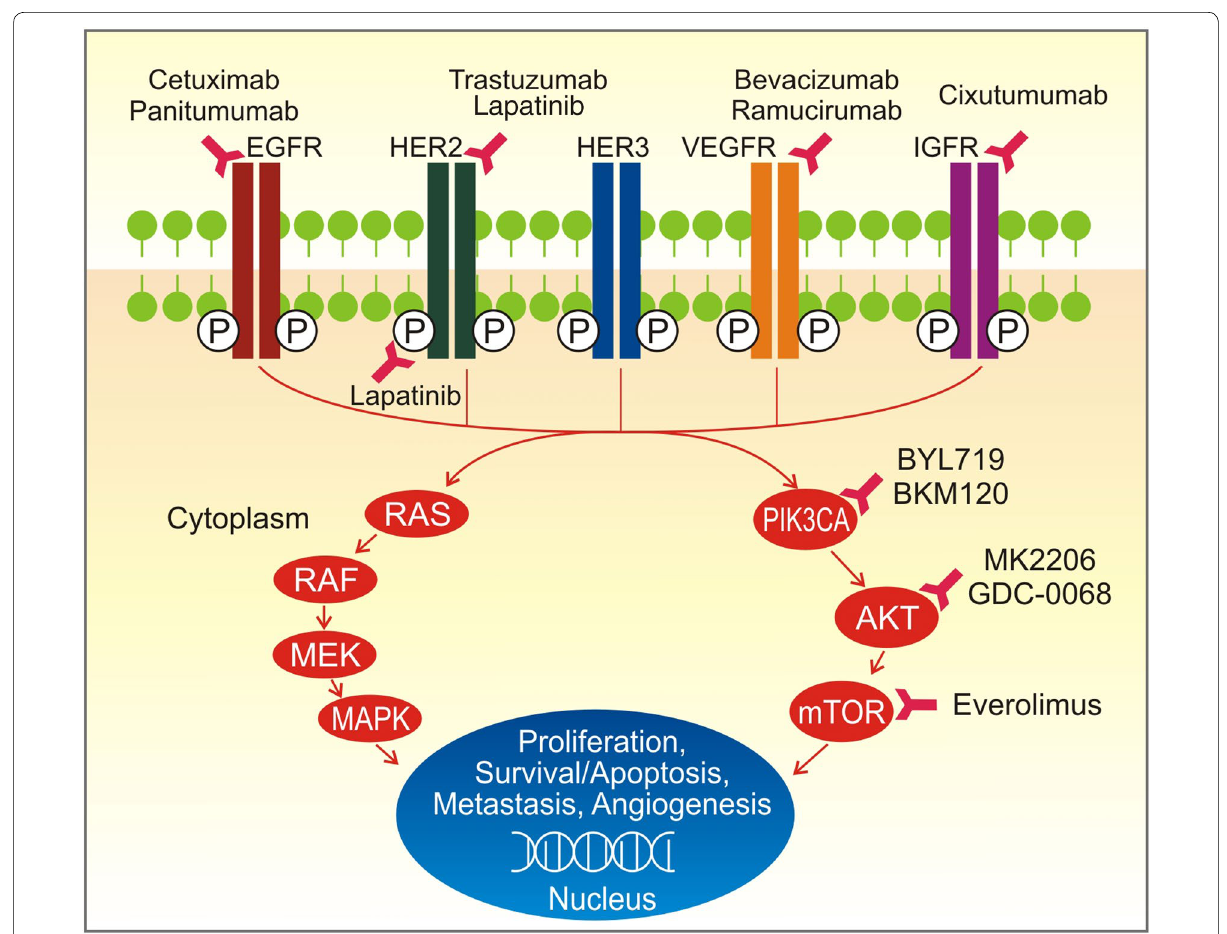
Fig. 3 The current targeted therapies for advanced GCs. EGFR epidermal growth factor receptor, HER2 erb‑b2 receptor tyrosine kinase 2, IGFR insulin‑like growth factor receptor, MEK MAP kinse‑ERK kinase, MAPK mitogen‑activated protein kinase. Other abbreviations as in Figs. 1, 2